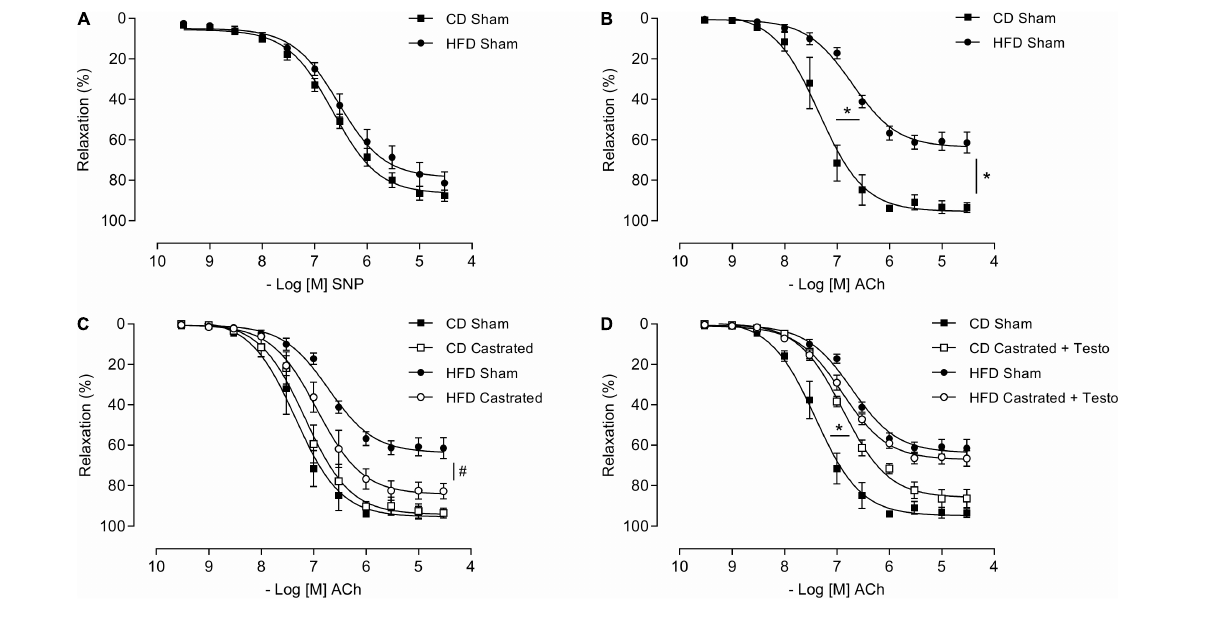
FIGURE 1 | Testosterone contributes to vascular dysfunction in high fat diet (HFD)-fed mice. Concentration-response curves to sodium nitroprusside - SNP (A) and acetylcholine (Ach) were performed in aortic rings isolated from control diet (CD) sham and HFD sham mice (B) . ACh responses were also determined in aortic rings from castrated mice fed either a CD or HFD (CD castrated and HFD castrated, respectively) (C) , and CD castrated and HFD castrated mice treated with testosterone propionate (5 mg/Kg for 15 days) (D) . Data are expressed as mean ± SEM ( n = 7 in all groups). * p < 0.05 vs . Sham; # p < 0.05 vs . HFD Sham. TABLE 2 | Emax and p D 2 values of sodium nitroprusside and acetylcholine-induced relaxation in thoracic aorta